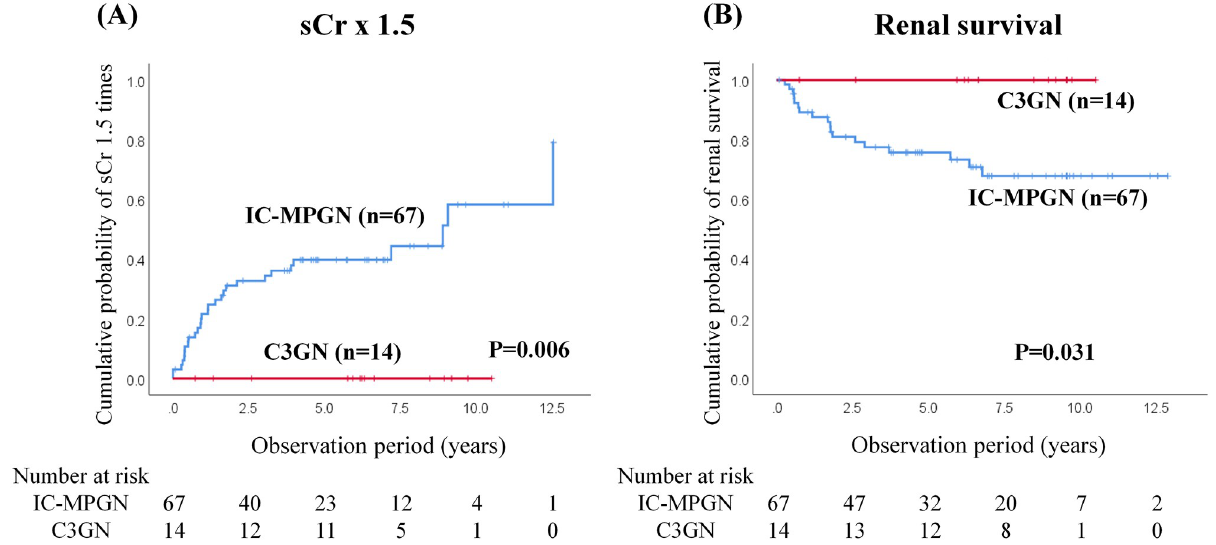
Fig 2. Renal outcomes of IC-MPGN and C3GN. Significant differences were observed in serum creatinine elevations of 50% (sCr × 1.5, A) and end- stage kidney disease (ESKD) (B) between IC-MPGN and C3GN patients. Kaplan-Meier curves for treated and untreated patients analyzed using log- rank tests. IC-MPGN, immune-complex membranoproliferative glomerulonephritis; C3GN, C3 glomerulonephritis. https://doi.org/10.1371/journal.pone.0257397.g002 median age (62 y).Although the subgroup of older patients with steroid pulse therapy was highest urinary proteinuria and lowest eGFR at baseline (Table 3), the both outcome of a 50% increase in creatinine and ESKD was better than the subgroup of older patients without steroid pulse therapy (Table 4), suggesting that some patients with IC-MPGN, even though older patients, might be amenable to treatment with steroid pulse therapy. Additionally, the ratio